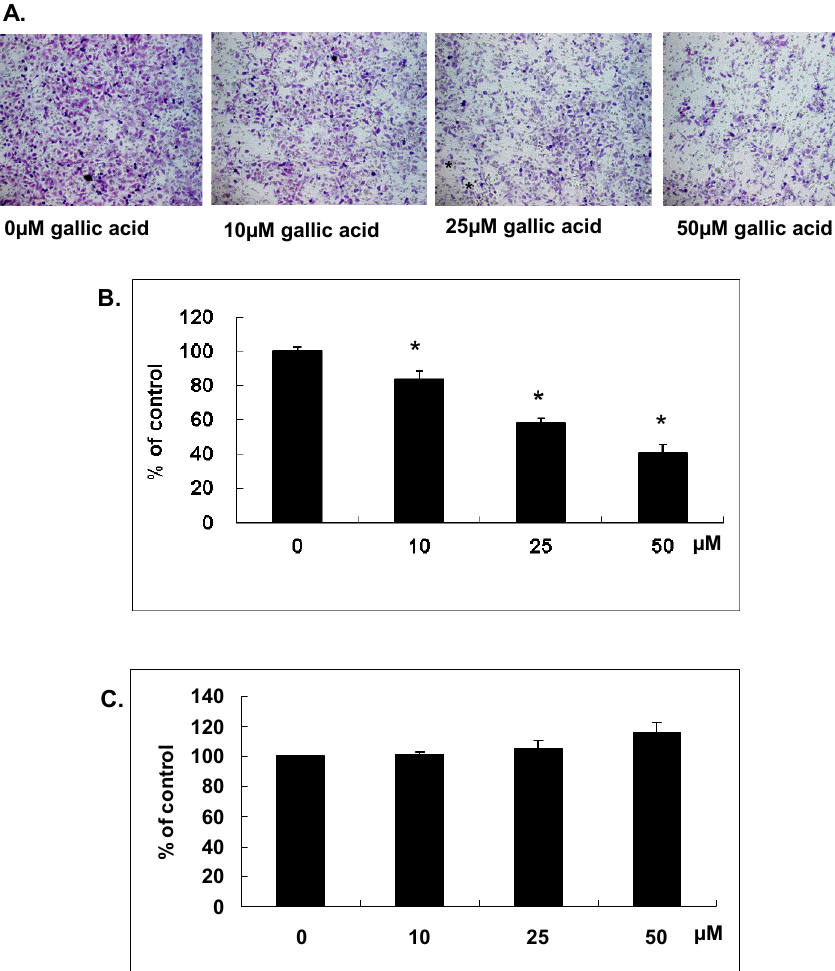
Figure 1. Gallic acid suppressed the in vitro matrix invasion. NPC-BM1 cells pretreated 24 h with different concentrations of gallic acid were allowed to invade for 2 h by transwell filter assay. ( A ) The cells on the lower surface of the filter were examined under contract microscope (HPF) (100 × ); ( B ) The inhibitory effect of gallic acid on NPC-BM1 invasion was demonstrated; ( C ) The cytotoxic effect of gallic acid was evaluated by the LDH assay using the conditioned medium collected from NPC-BM1 treated with different concentrations of gallic acid for 24 h. There was no cytotoxicity detected under the experimental conditions. Data were mean ± SD calculated from three individual experiments. An asterisk demonstrated the significant difference (* p < 0.05) compared with control.